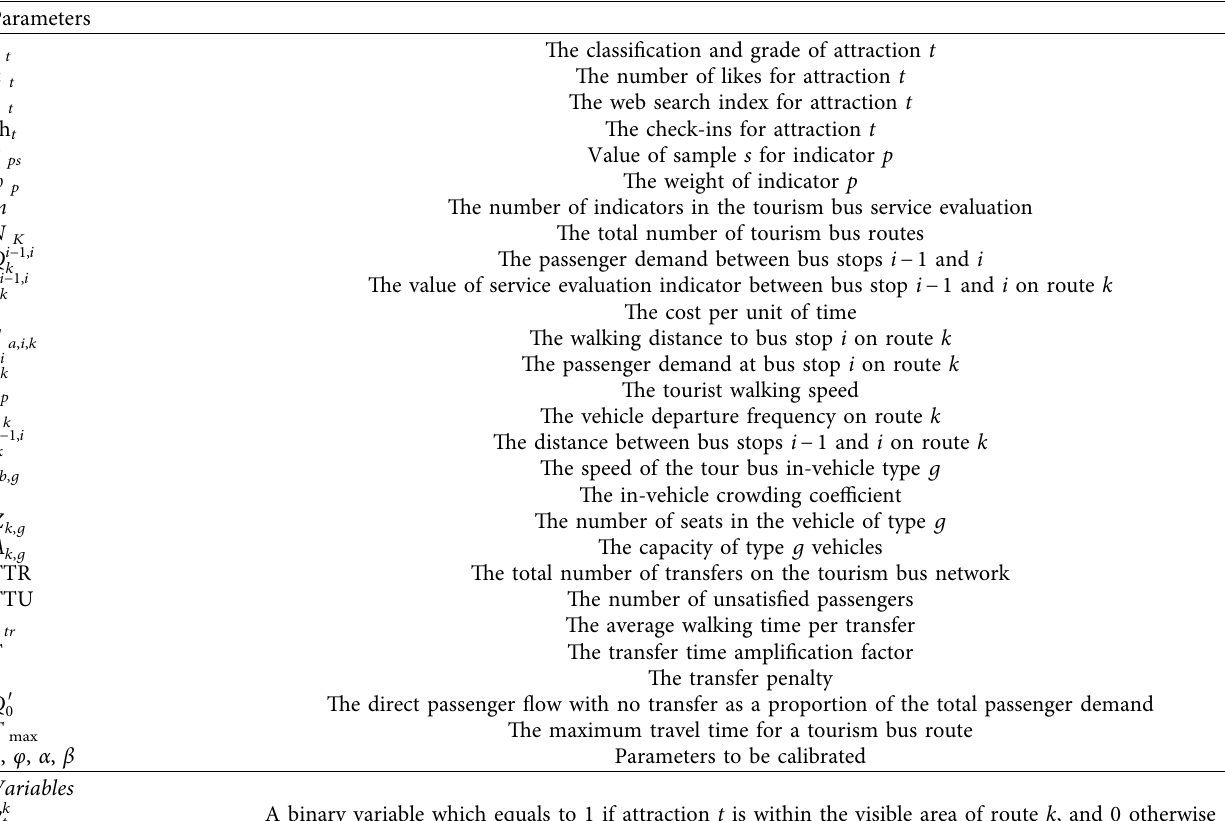
Table 1: List of notations.